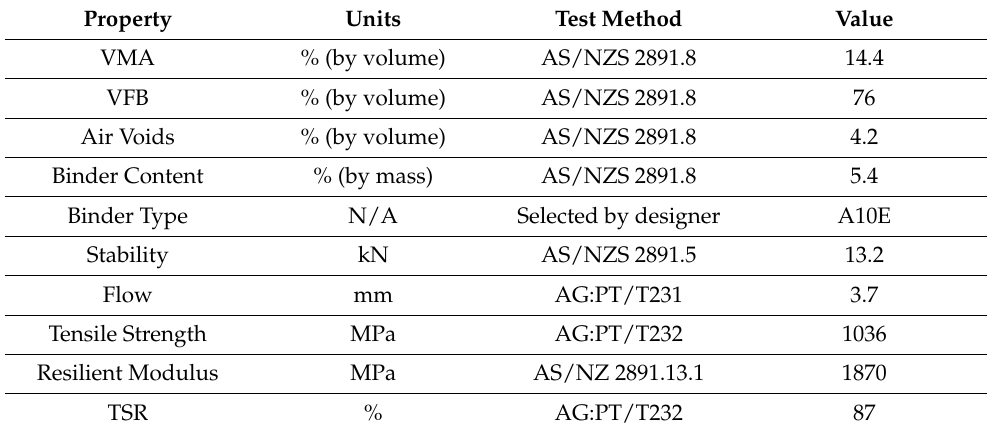
Table 1. Volumetric properties of DGA [36].